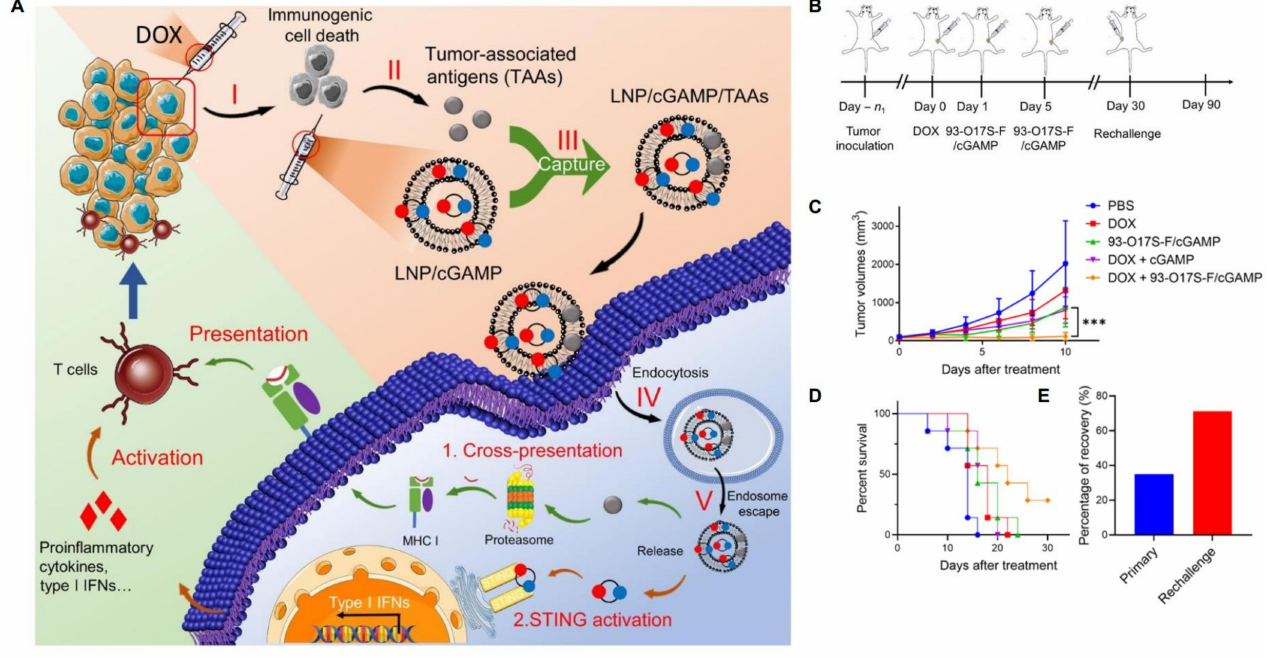
Figure 7. ( A ) Study design and description of in situ vaccination experiments using lipid